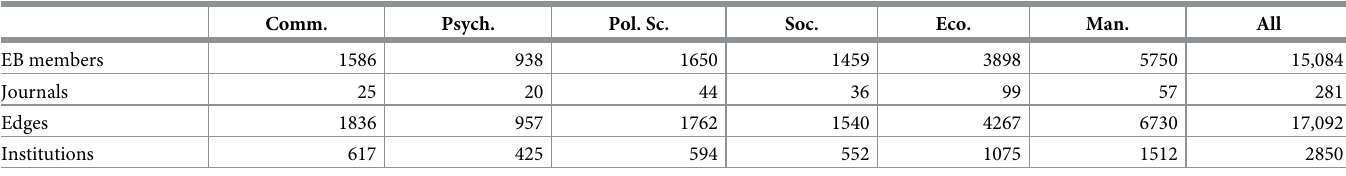
Table 1. Sample for each field and for the complete network. Comm.